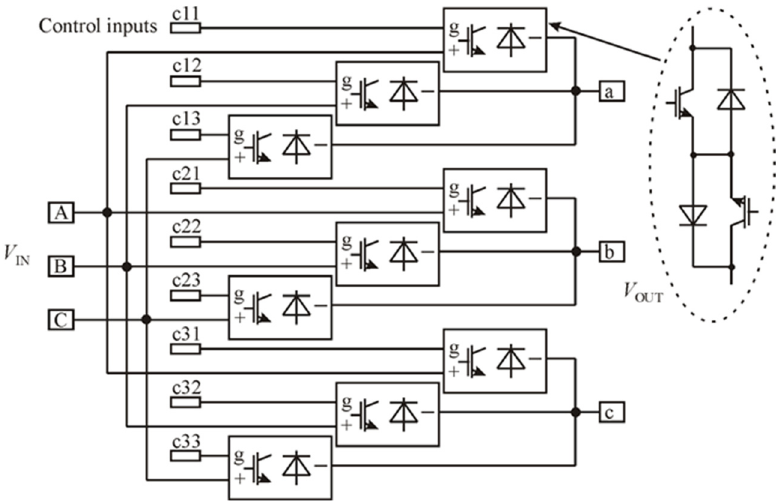
Figure 12. Structure the simulation model of nine ideal bidirectional